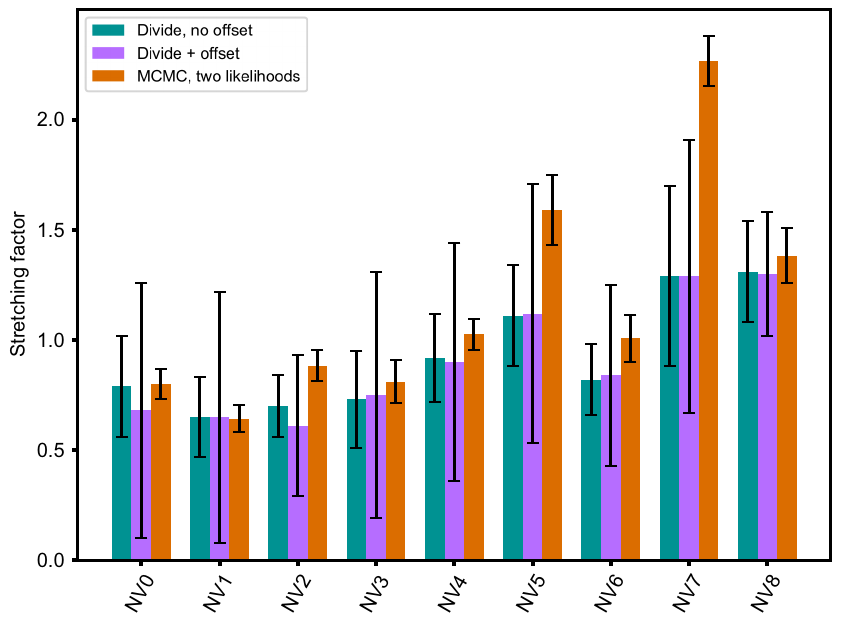
FIG. 19. Comparison of fitting meth- ods. Sample of fitted stretching factors for NV centers in isotopically purified sam- ples. Including an offset does not generally change the fitted value of the stretching factor, but it does introduce additional error. MCMC fitting using two likelihoods produces more constrained parameter fits, and systematically fits slightly higher val- ues of n